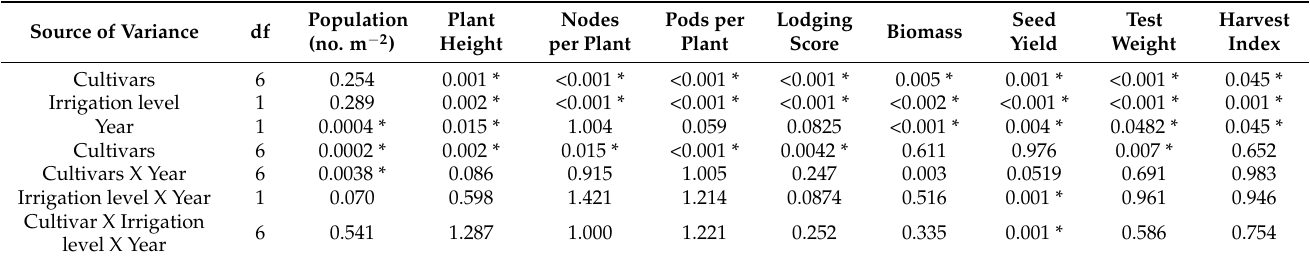
Table 4. Significance of the main effects of cultivars, irrigation regimes, and year, and their interactions. Source of Variance